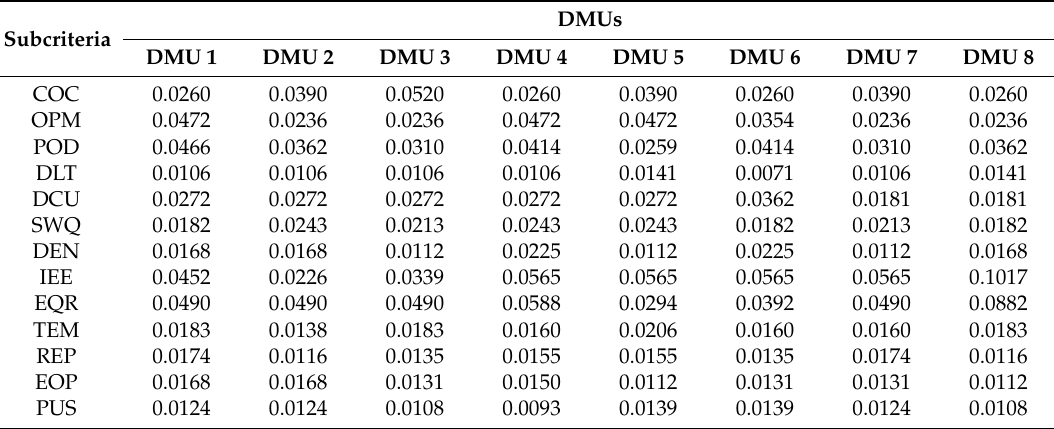
Table 10. Normalized weight matrix